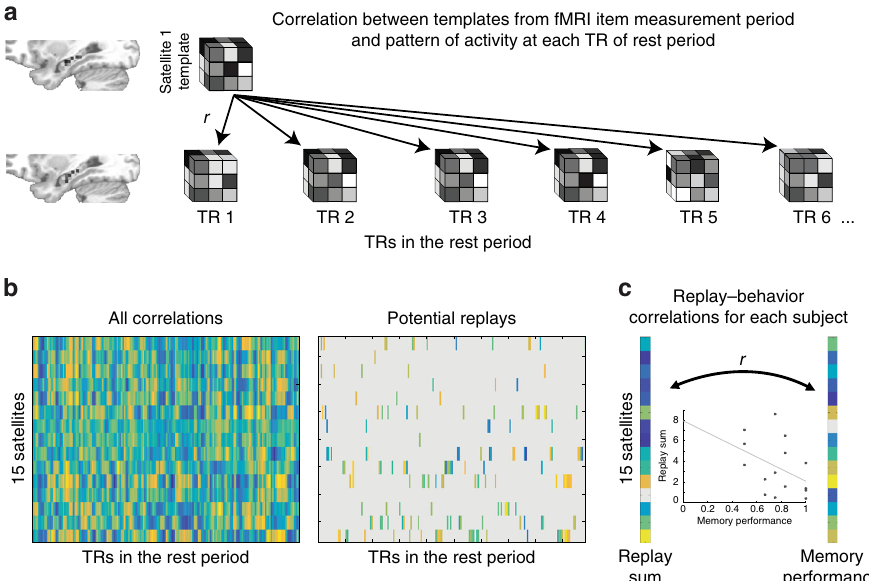
Fig. 3 Replay analysis. a Each satellite ’ s template consists of a pattern of beta weights across all voxels in the hippocampus. The template is correlated with the preprocessed pattern of activity across all voxels in the hippocampus at each TR of the rest period. b This results in a matrix of correlation values between all templates and all rest period TRs, which is then thresholded to re fl ect “ potential replays ” . c The potential replay activity for a given template is summed across TRs and then correlated with memory performance. The inset scatterplot shows data for one representative subject ’ s Session 1